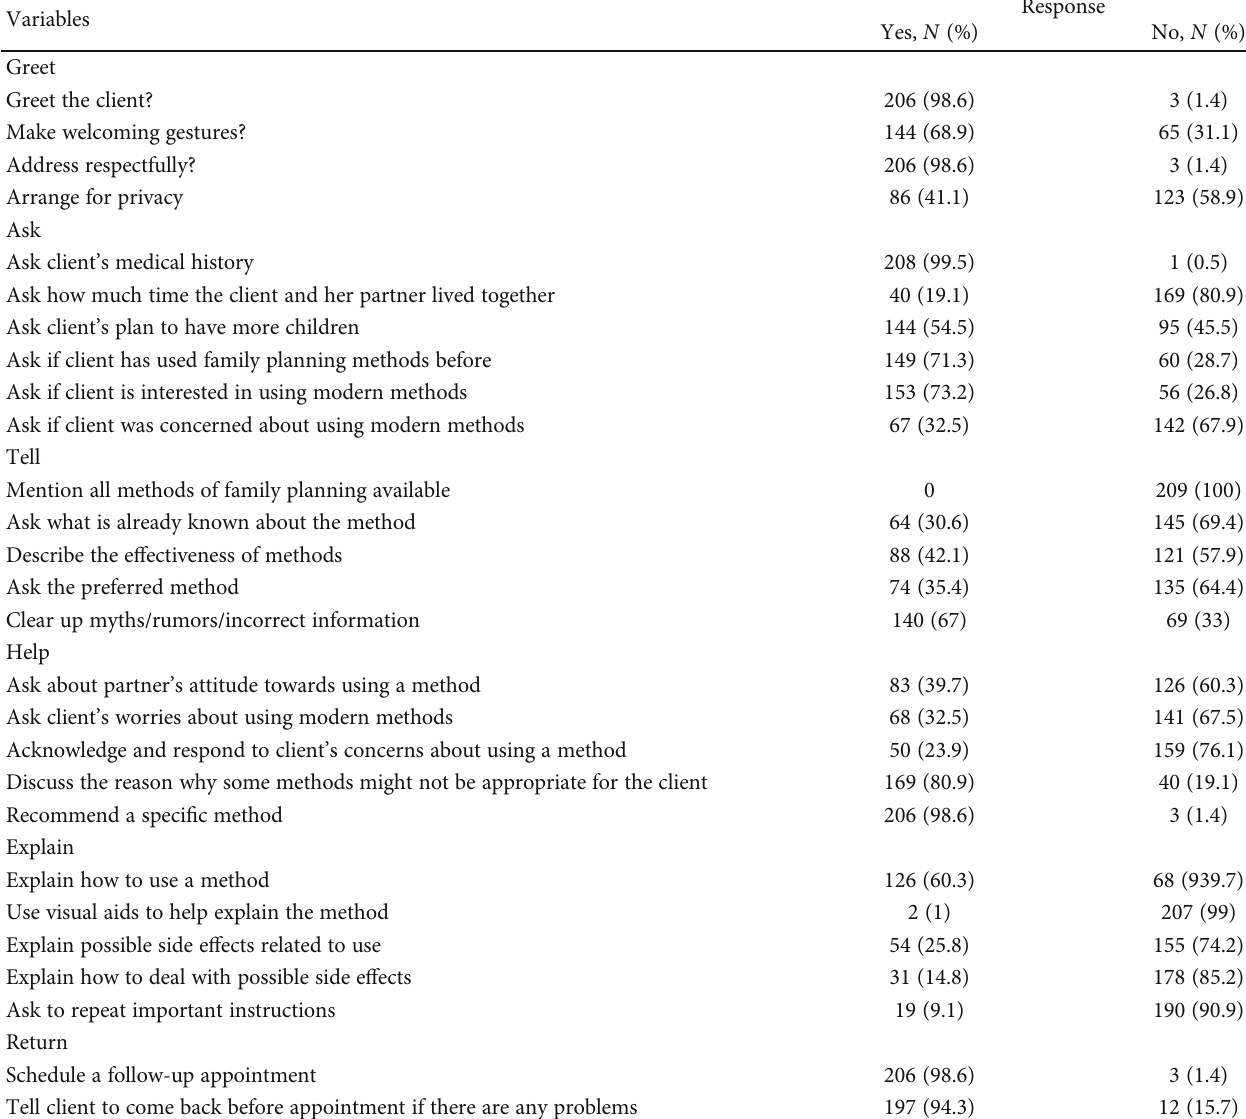
Table 2: Level of family planning counseling utilizing the GATHER framework, Addis Ababa, Ethiopia